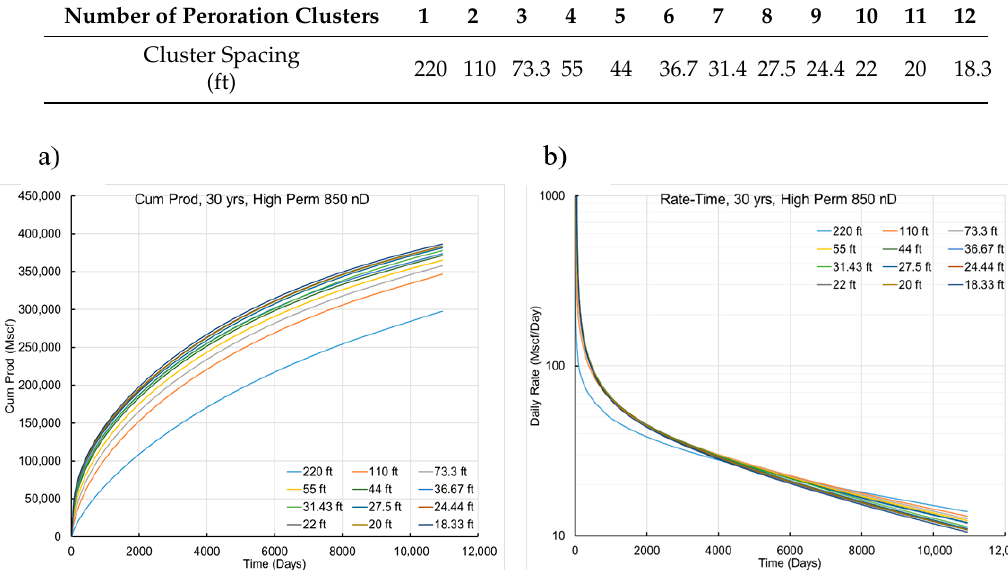
Table 1. Spacing range (in ft) of fracture clusters used in the sensitivity study of well performance to fracture spacing.